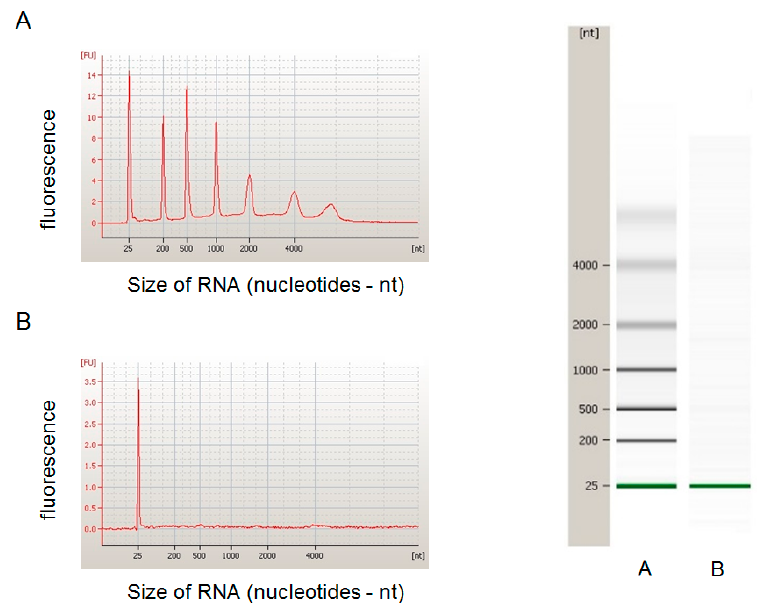
Figure 1. Electropherogram and gel-like image of RNA sample extracted from salivary exosome. Y -axis: fluorescence intensity in fluorescence units (FU), X -axis: nucleotides (nt). ( A ) RNA ladder; ( B ) An extracted RNA sample.